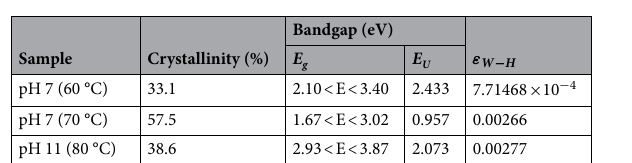
Figure 13. The absorption coefficient plots of Cu-based oxide nanostructures prepared at ( a ) 60, ( b ) 70 and ( c ) 80 °C. The curves are calculated using absorbance data with the best linear fitting model. The ln α scale yields the absorption edge of the Urbach region.